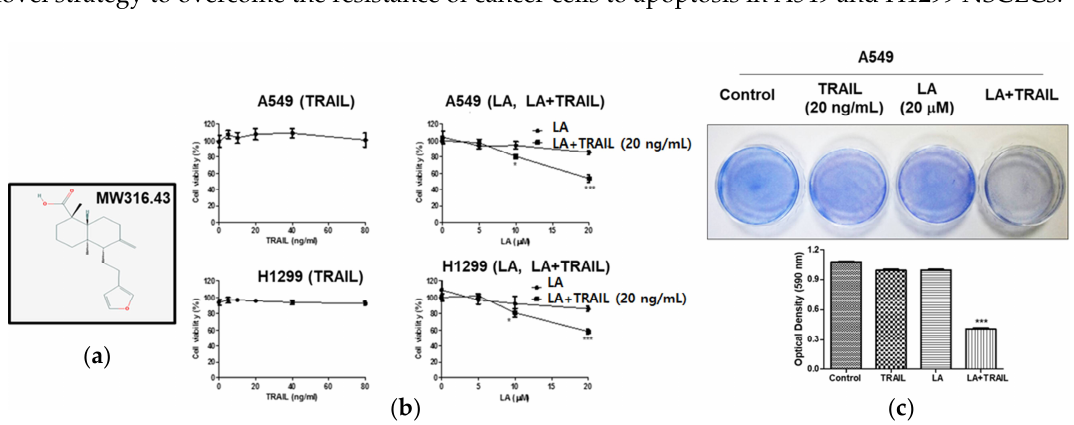
Figure 1. Cytotoxicity of the combination of lambertianic acid (LA) and tumor necrosis factor-related apoptosis-inducing ligand (TRAIL) in A549 and H1299 non-small cell lung cancer cells. ( a ) Chemical structure of LA. Molecular weight = 316.43. ( b ) Cell viability was evaluated by 3-(4,5-dimethylthiazol- 2-yl)-2,5-diphenyltetrazolium bromide (MTT) assay. Cells were seeded onto 96 well microplates and treated with various concentrations of LA (0, 5, 10, 20 μM) and TRAIL (0, 20, 40, 80 ng/mL) for 24 h. The cytotoxic effects of LA (20 μM) and TRAIL (20 ng/mL) on TRAIL in A549 and H1299 cells. Data represent means ± SD. * p < 0.05, *** p < 0.001 versus LA-treated control ( n = 3). ( c ) A549 cells were treated with LA (20 μM) and/or TRAIL (20 ng/mL) for 24 h and then stained with crystal violet. Data represent means ± SD. *** p < 0.001 versus TRAIL alone ( n = 4).